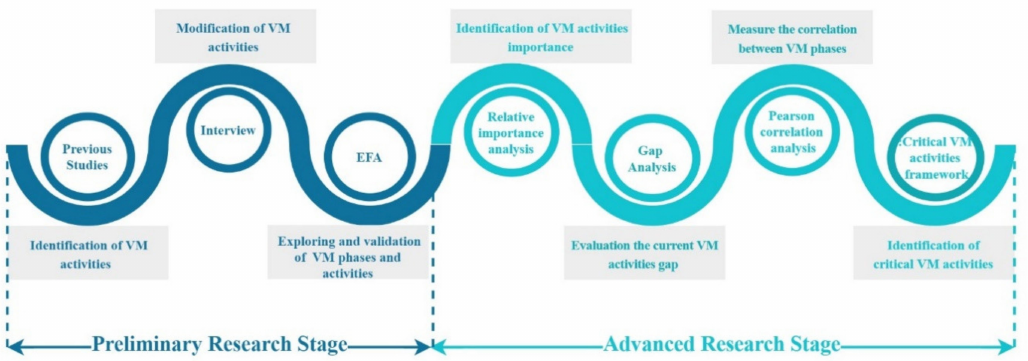
Figure 4. Research process adapted from